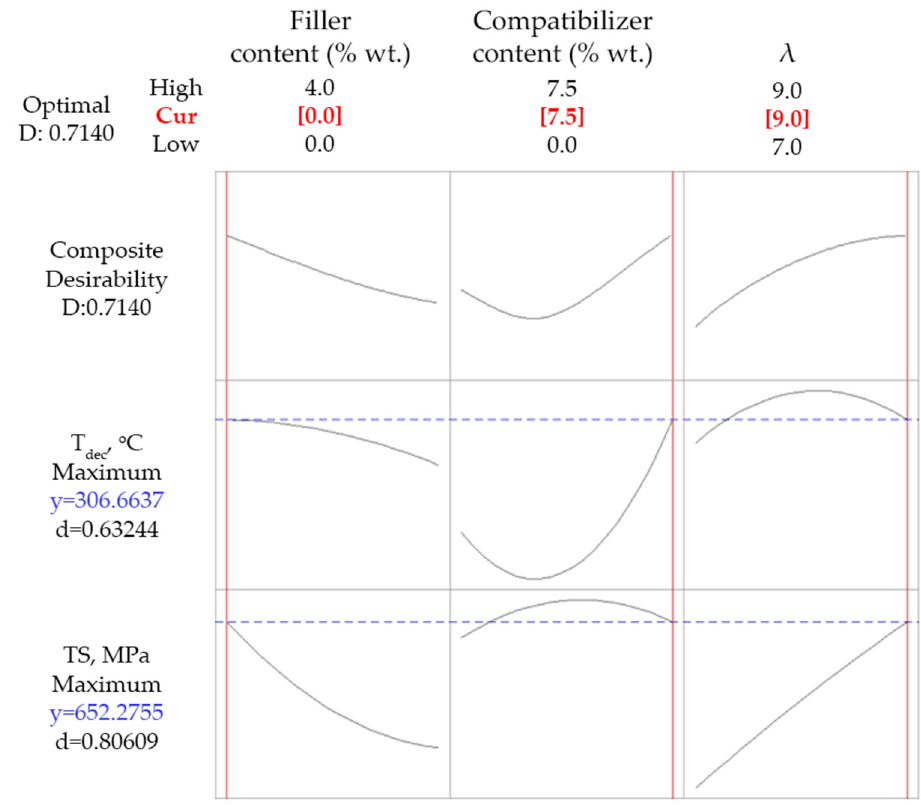
Figure 3. Optimization results targeting simultaneous maximization of TS and T dec for composites with talc.